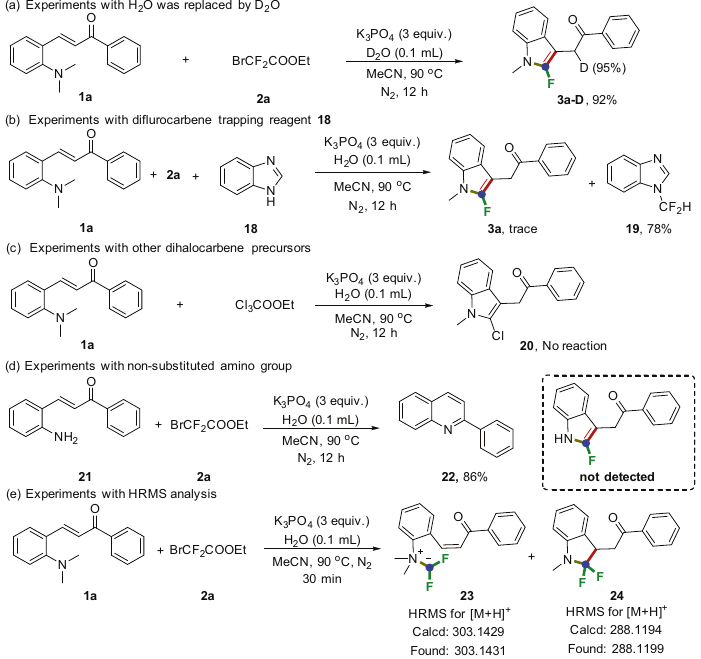
Fig. 7 Control experiments. a Deuterium-labeling experiment. b Di fl urocarbene trapping. c Control experiment of dichlorocarbene. d Experiments with non-substituted amino group. e Experiments with HRMS